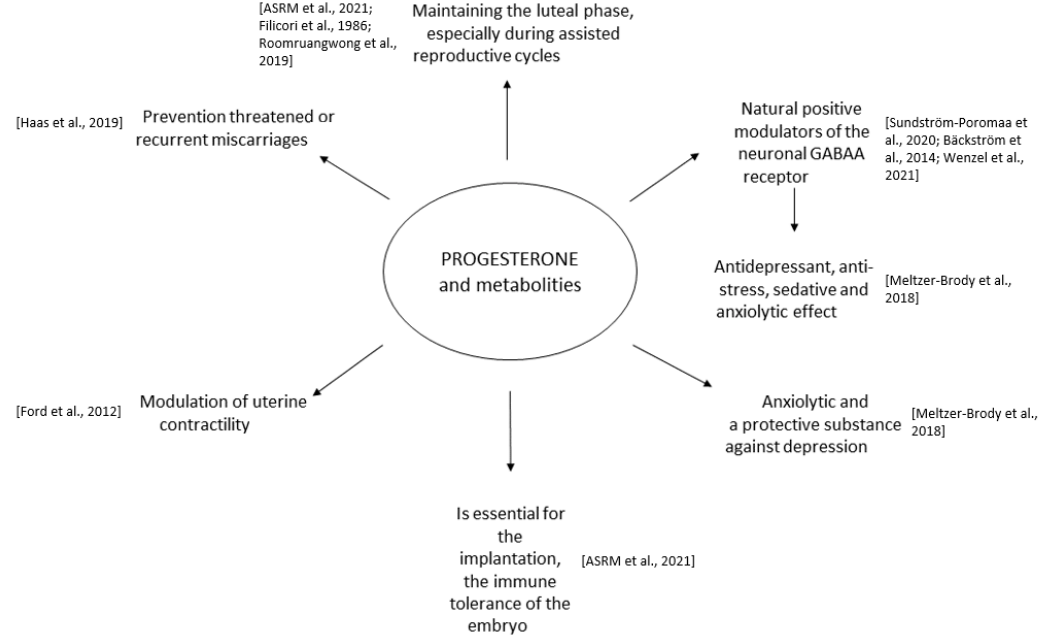
Figure 1. Pharmacodynamic profile of progesterone [7–10,12–14,16,34].